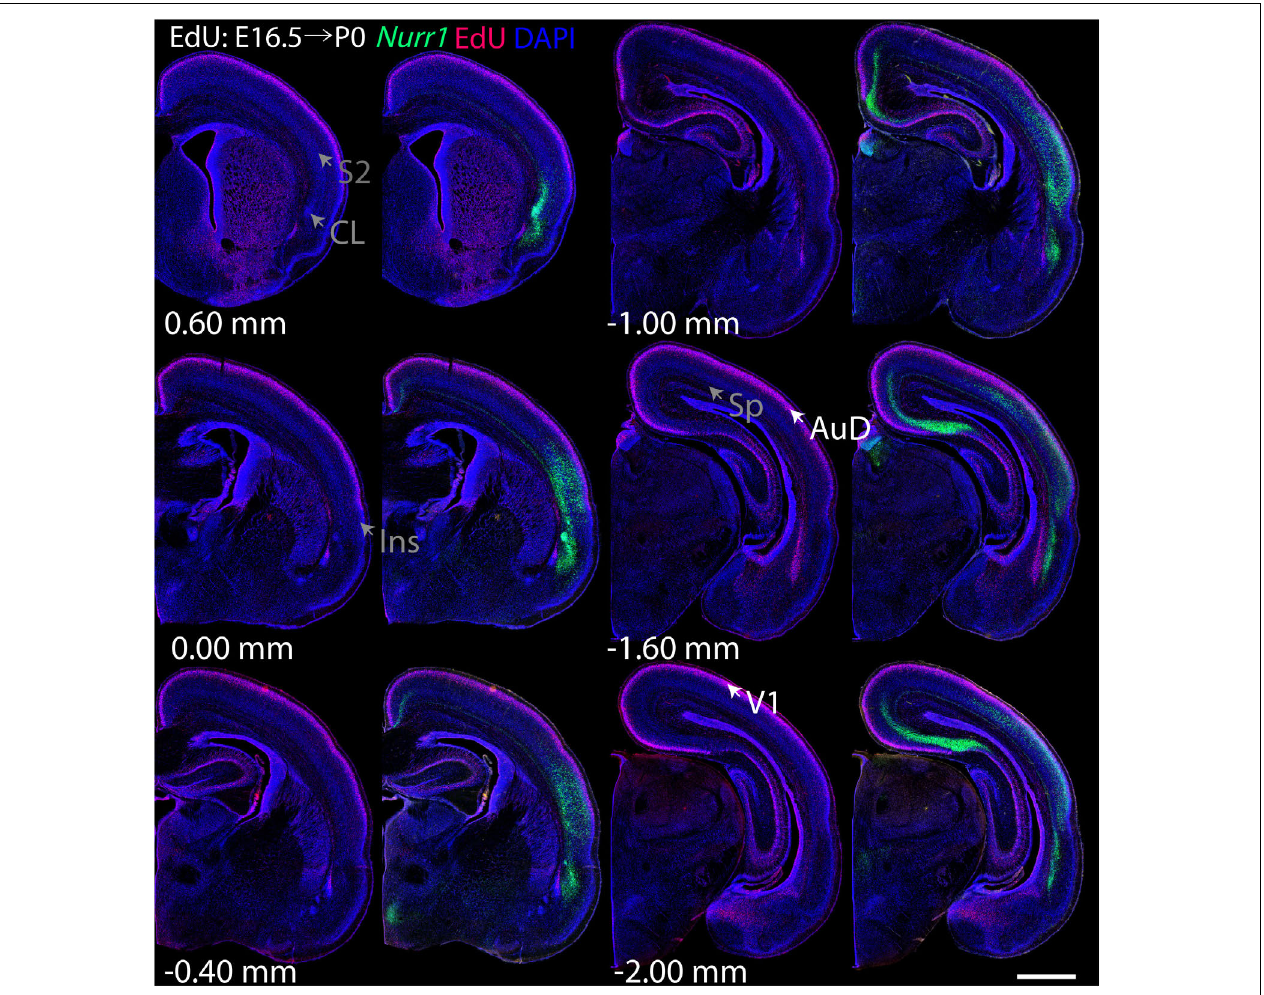
FIGURE 8 | Overview of EdU labeling on E16.5 with Nurr1 FISH on P0. White arrows indicate the EdU labeled regions. Gray arrows indicate the regions with reduced EdU labeling. AuD secondary auditory cortex, V1, primary visual cortex dorsal area, S2, secondary somatosensory cortex, CL, claustrum, Ins, insular cortex, Sp, subplate. Numbers below sections indicate the bregma coordinate. N = 3 rats. Scale bar = 1